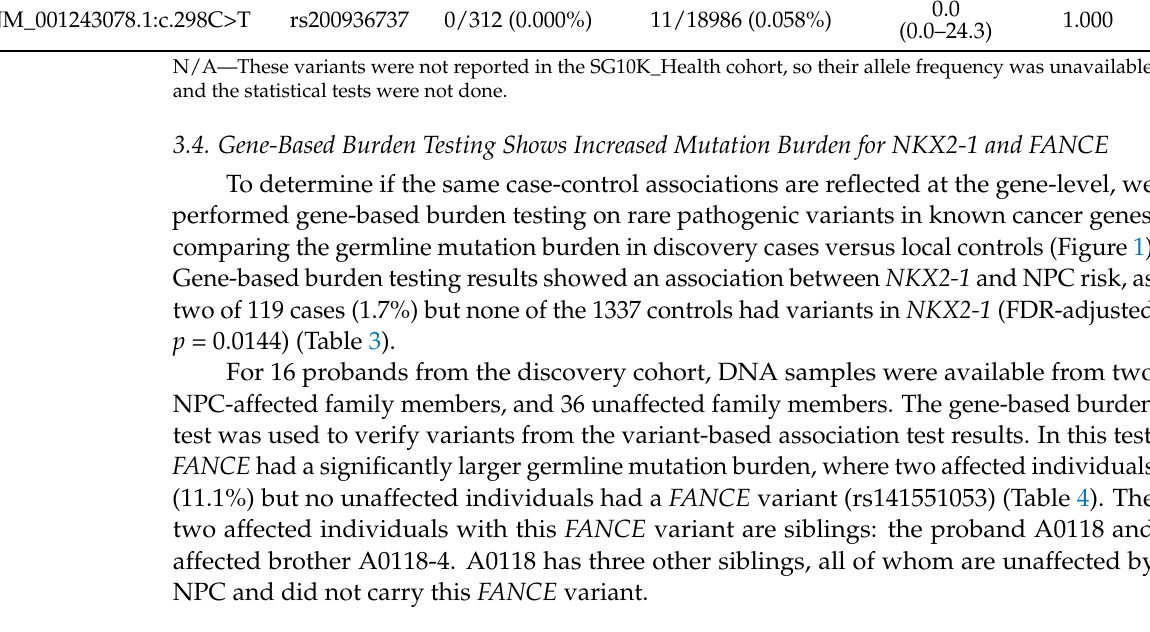
Table 3. Gene-based burden testing of 17 prioritised candidate